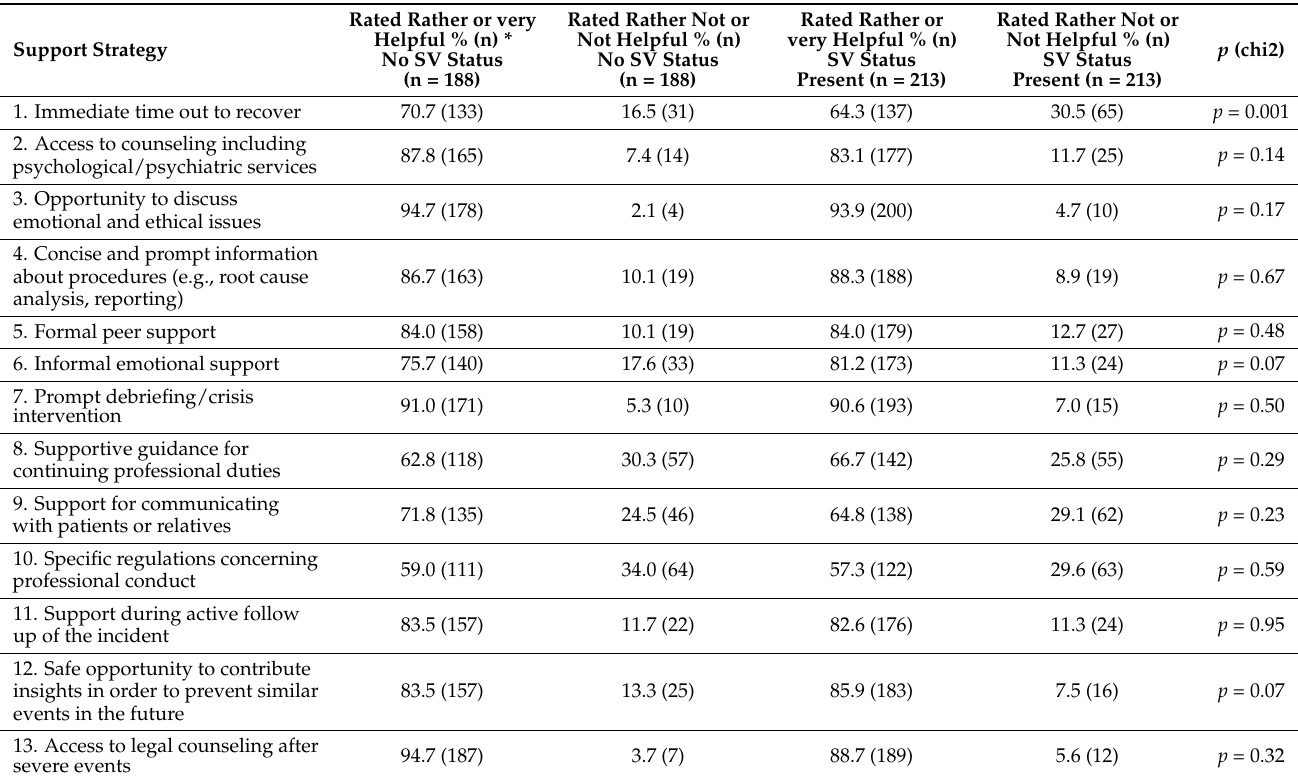
Table 6. Ratings of Support Strategies subject to Second Victim (SV)